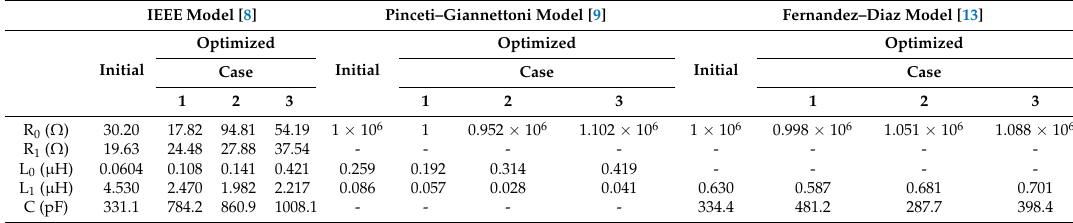
Figure 7. Results for the IEEE model. Table 2. Initial and optimized parameters for each model and each case.